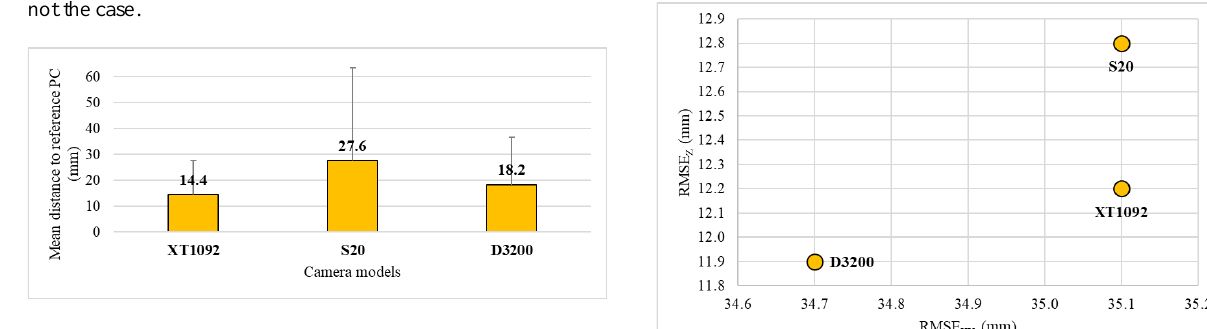
Figure 5 . C2C distances between SfM and reference PCs.